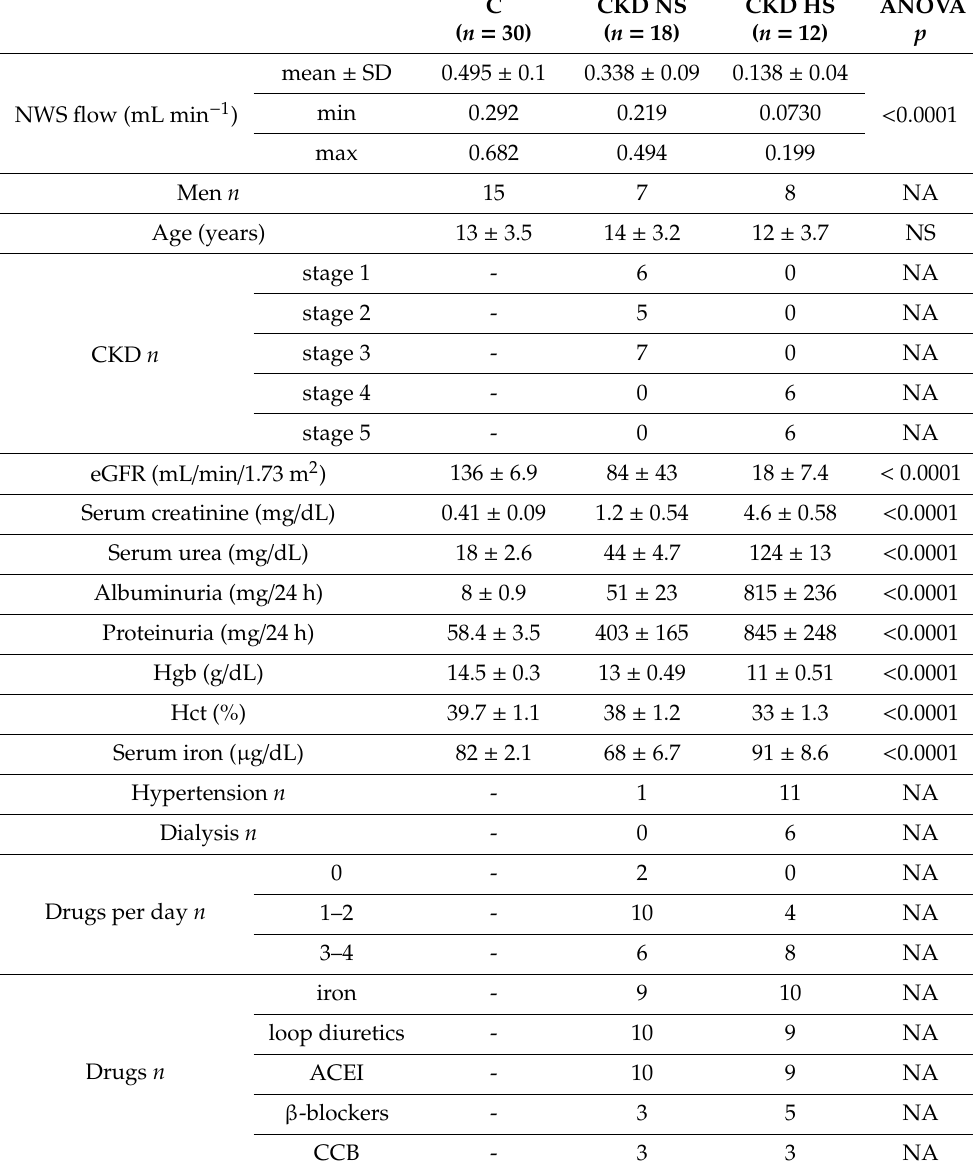
Table 1. Clinical characteristics of children with chronic kidney disease (CKD) and healthy